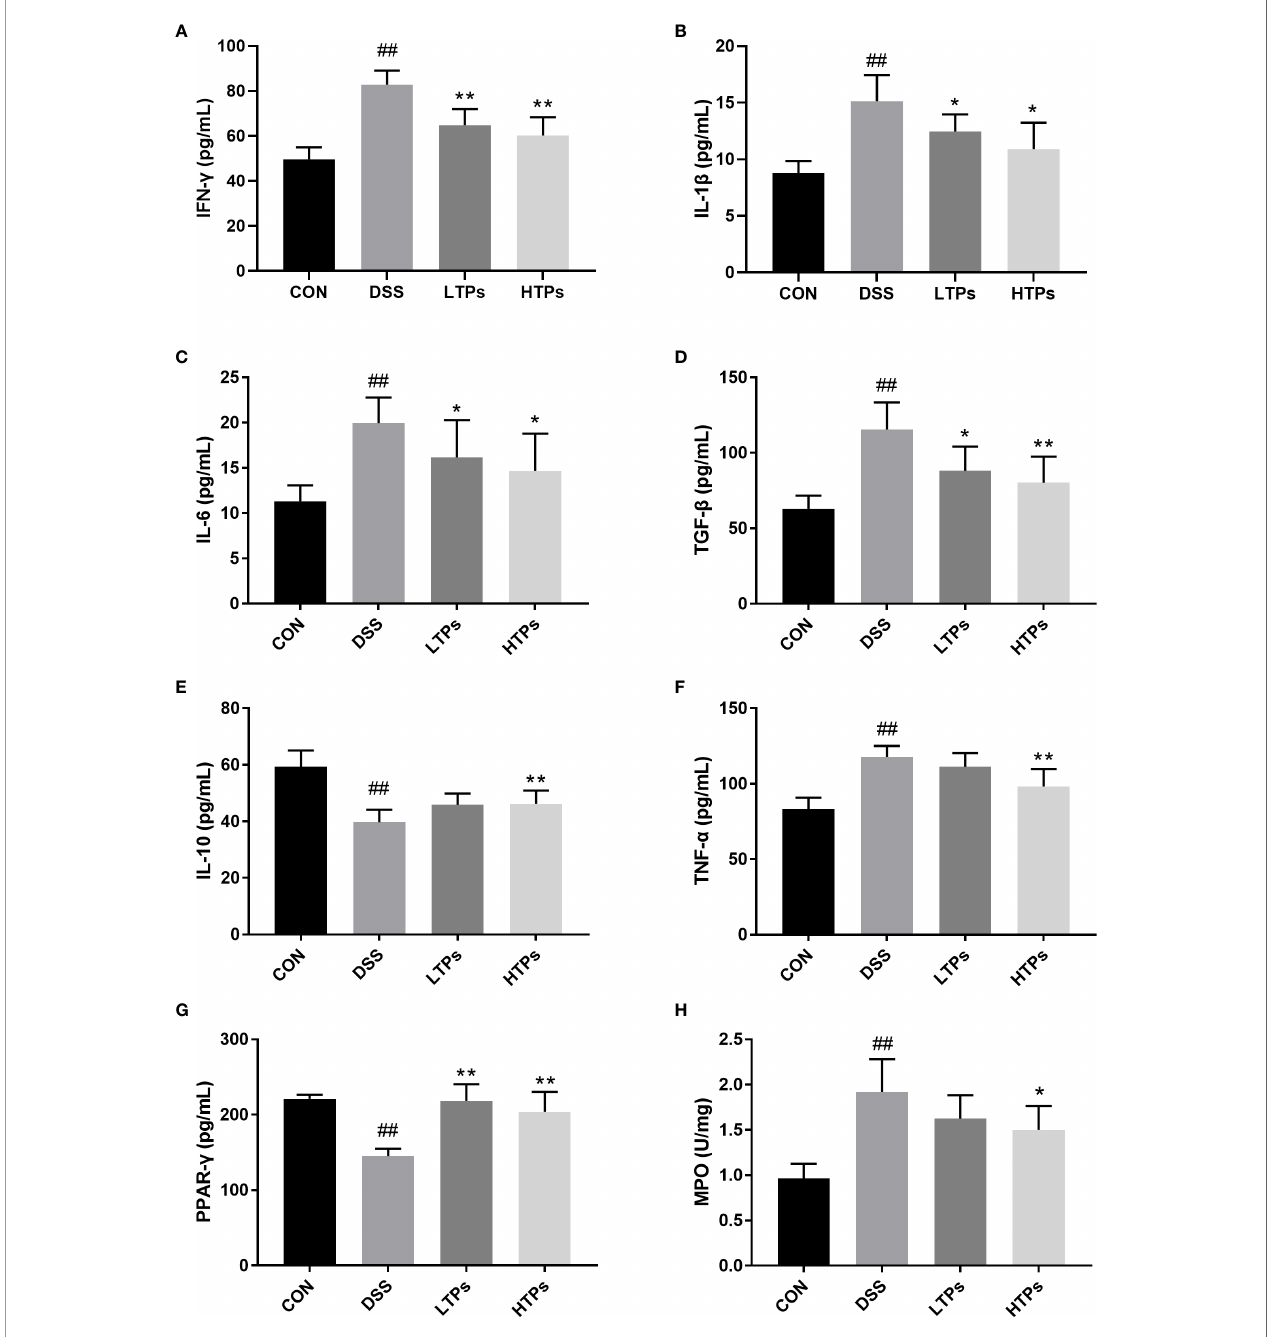
FIGURE 4 | Quanti fi cation of the concentrations of IFN- g (A) , IL-1 b (B) , IL-6 (C) , TGF- b (D) , IL-10 (E) , TNF- a (F) , PPAR- g (G) and MPO (H) activity in colon. All values are represented as mean ± SD ( n = 6). CON, Control group; DSS, DSS challenge group; LTPs, DSS challenge + 200 mg/kg TPs; HTPs, DSS challenge +300 mg/kg TPs. # p < 0.05, ## p < 0.01 v . normal group. * p < 0.05, ** p < 0.01 v . control